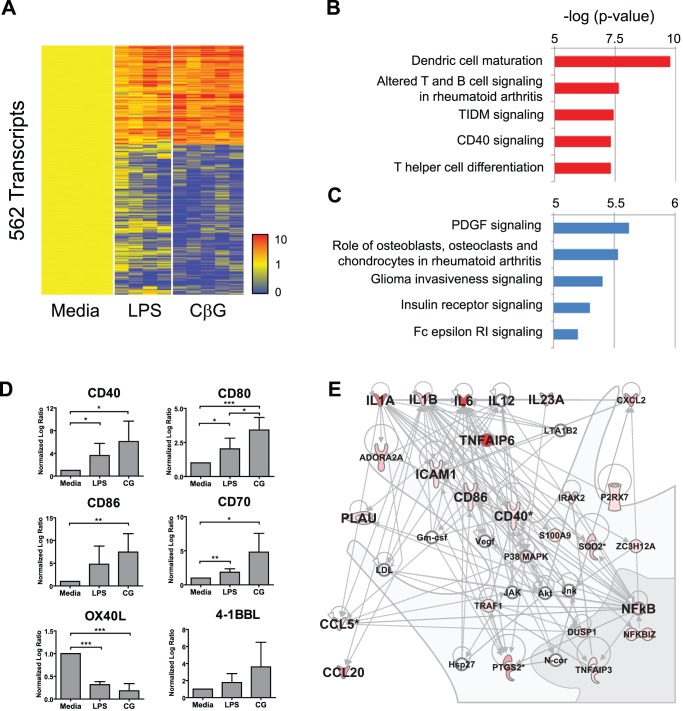

B. melitensis CβG induces over-expression of mRNA transcripts linked to DC maturation and T cell activation in human blood mDC.(A) Transcripts significantly over/under expressed 2-fold in mDC activated 6 h in vitro with CβG (5 donors, data normalized to 6 h activation with media control per donor). (B) Top canonical pathways identified by Ingenuity Pathway Analysis (IPA) for genes over-expressed in CβG-activated mDC. (C) Top canonical pathways identified by Ingenuity Pathway Analysis (IPA) for genes under-expressed in CβG-activated mDC. (D) Bar charts representing the mean normalized log ratio expression of T cell costimulatory molecules mRNA in mDC activated for 6 h with media (n = 5), LPS (n = 4) or CβG (CG) (n = 5). Bars represent the standard deviation. (E) Top transcriptional network identified by IPA for genes over-expressed in CβG-activated mDC. Increase in color intensity represents increase in fold-change compared to 6 h media control treatment. ***p<0.001, **p<0.01, *p<0.05.